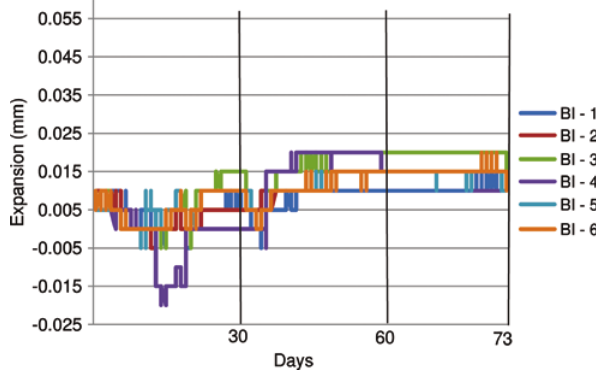
Figure 11 The results of expansion measurements for samples labelled BI-DT after the Duggan test.